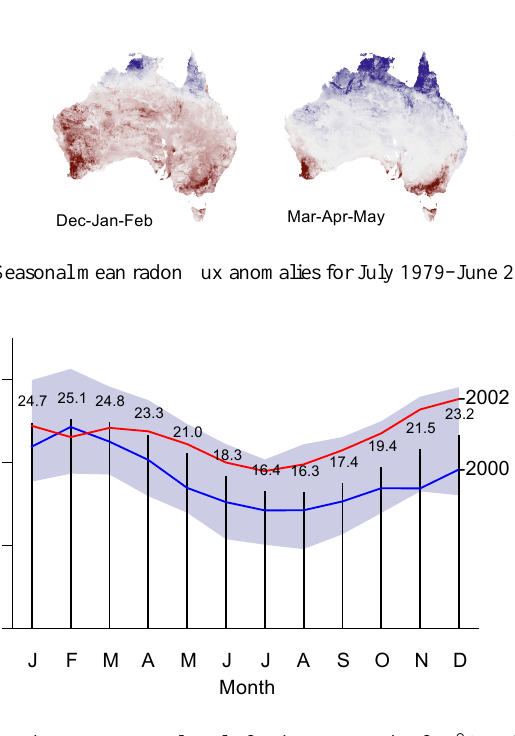
Fig. 11. Radon flux seasonal cycle for the area south of 30 ◦ S and east of 140 ◦ E, July 1979–June 2010. Labelled bars show the mean, the shaded region shows the range and examples of two years are also shown, 2002 (a relatively dry year) and 2000 (a relatively wet year).